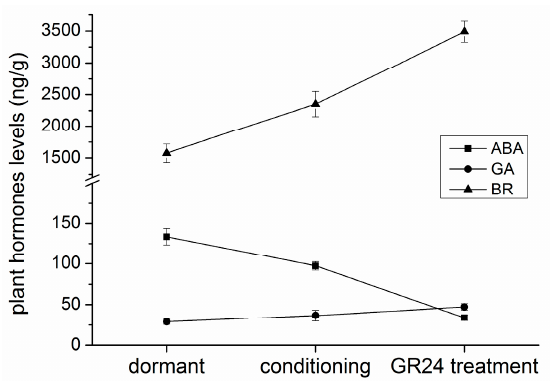
Figure 7. Time course of ABA, GA3, and brassinosteroid (BR) contents in P. aegyptiaca seed germination. Seeds were conditioned in water at 25 °C in the dark for 7 days and then conditioned in GR24 (10 − 6 mol/L) at 25 °C for 1 day.